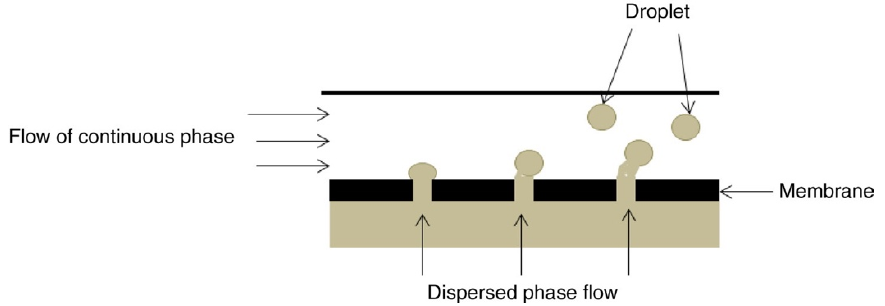
Figure 3. Membrane emulsification (reproduced with permission) [ 182].